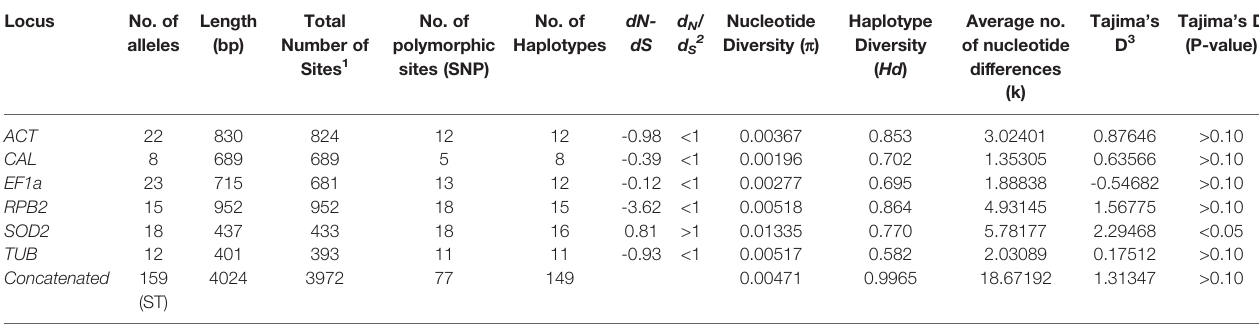
TABLE 2 | Neutrality and genetic variability tests performed on each MLST locus. Locus No. of Length alleles